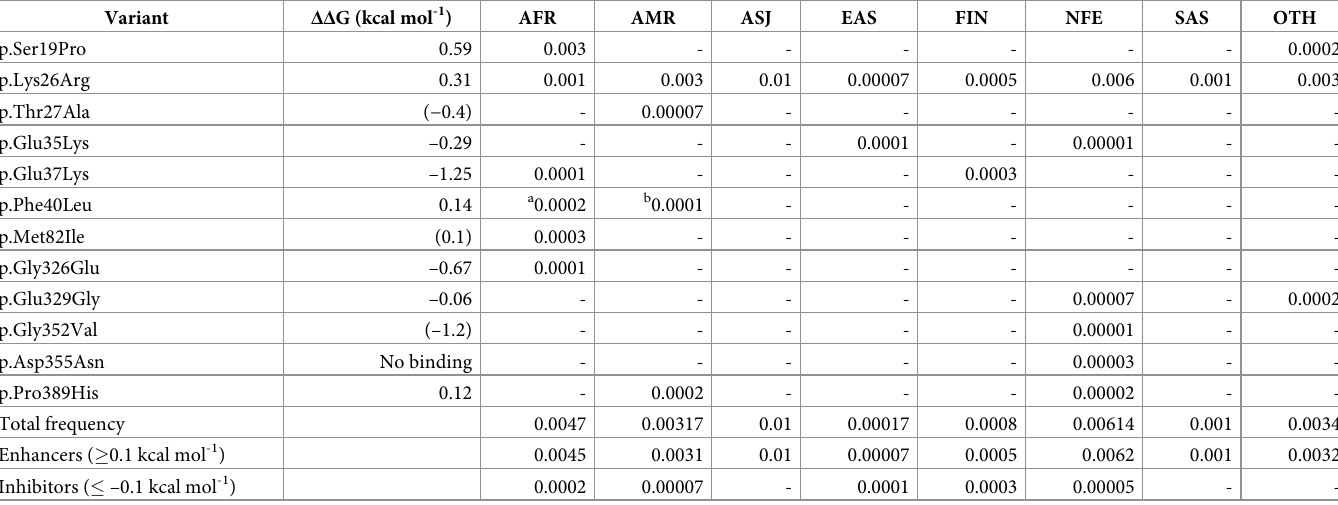
Table 4. Detailed prevalence data from gnomAD [24] for ACE2 variants reported in Table